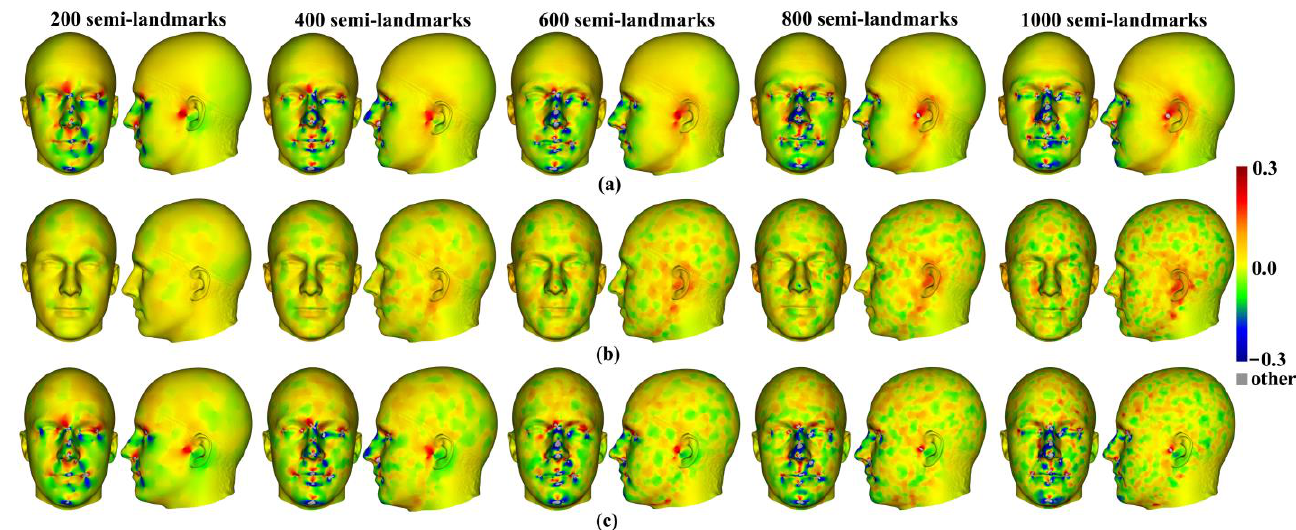
Figure 3. Visualization of the differences in mesh triangle surface areas between mean surface shapes generated using different semilandmarking approaches. ( a ) Differences between sliding TPS (reference) and LS&ICP (target) approaches. ( b ) Differences between sliding TPS (reference) and TPS&NICP (target) approaches. ( c ) Differences between TPS&NICP (reference) and LS&ICP (target) approaches. Scale bar indicates difference in local area between reference and target surfaces expressed as a proportion of the reference area.